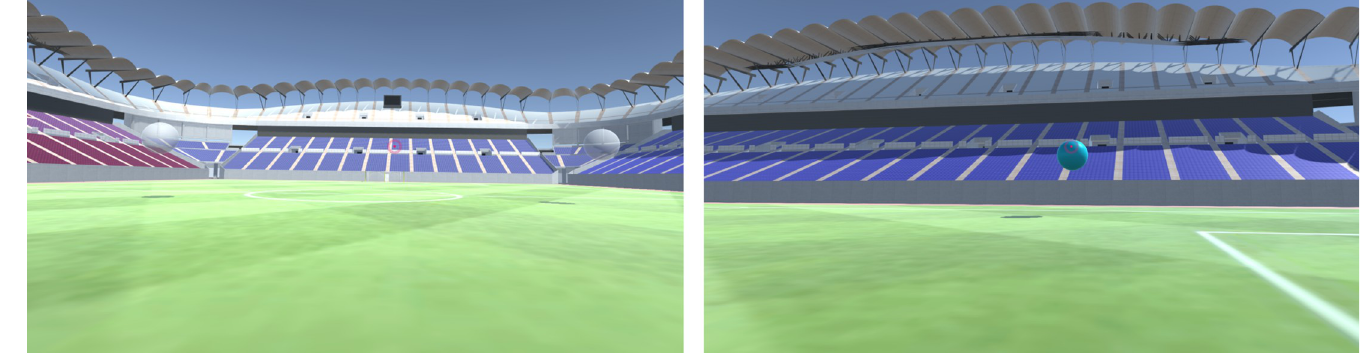
Fig 8. “Look at the spheres” scene. Left shows two white spheres in their initial state, while right shows the user gazing at a blue sphere.